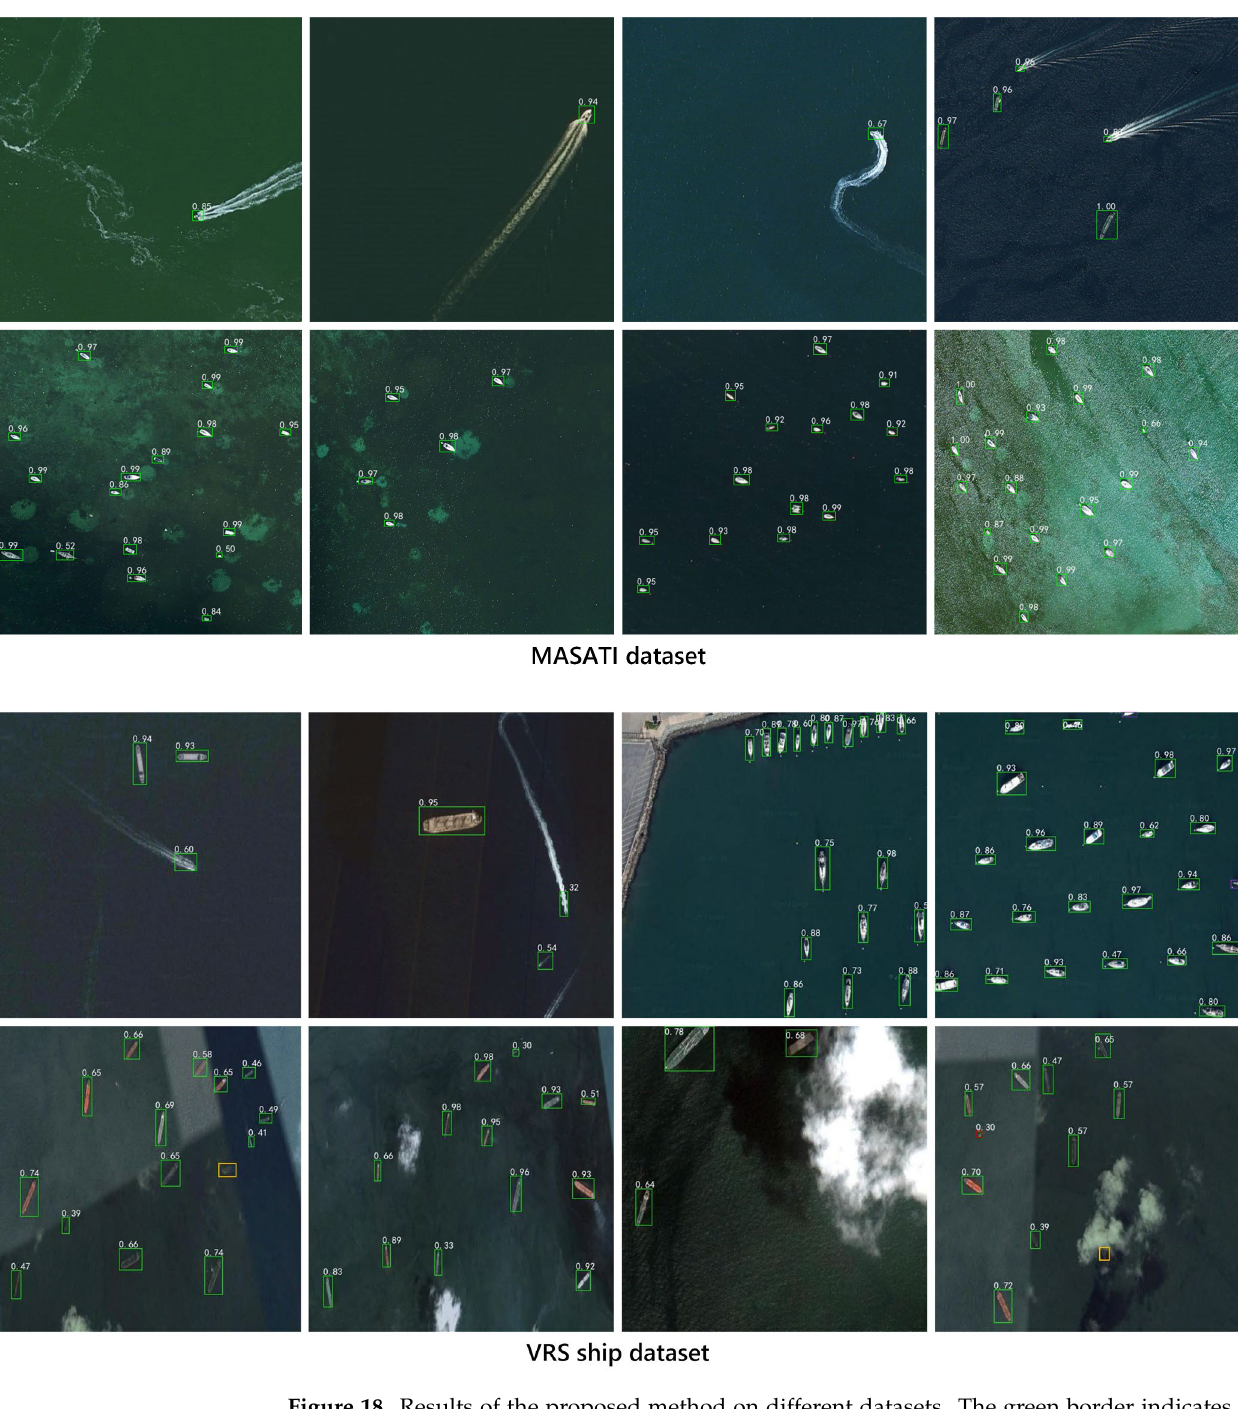
Figure 18. Results of the proposed method on different datasets. The green border indicates the correct targets detected, the red border indicates the misdetection results, and the orange border indicates the missed detection ships.